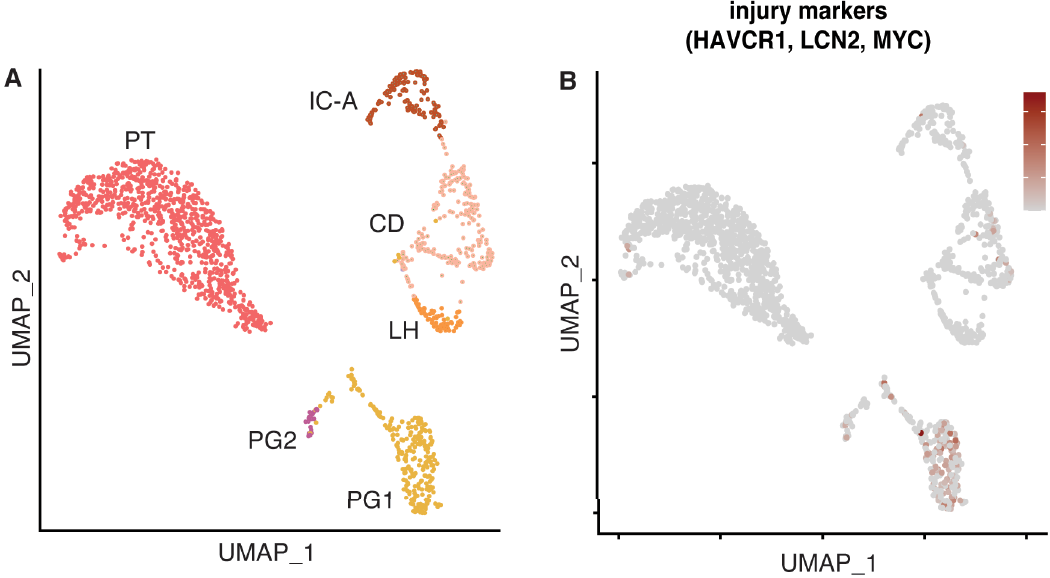
Fig 10. Analysis of kidney epithelial cell subpopulations. Figure depicts UMAP-based visualization of epithelial cell groups. (A). UMAP-based visualization of epithelial cells. (B). Feature plot showing co-expression of kidney injury markers HAVCR1 , LCN2 , and MYC